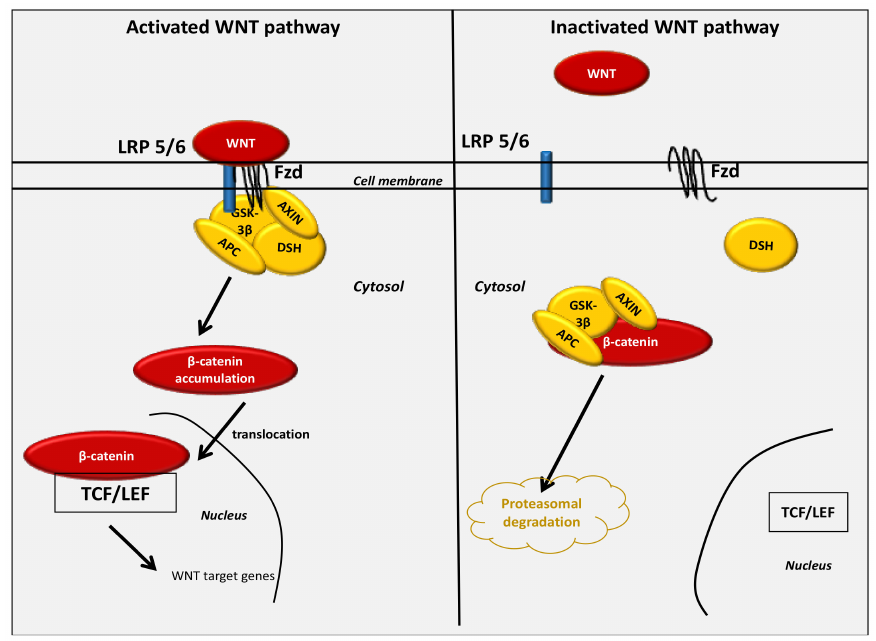
Figure 1. The activated and inactivated WNT/ β -catenin